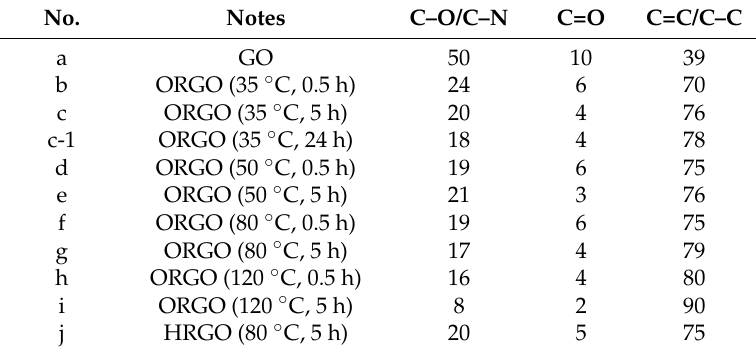
Table 1. The aspect ratio of different C in the XPS C 1s spectra.